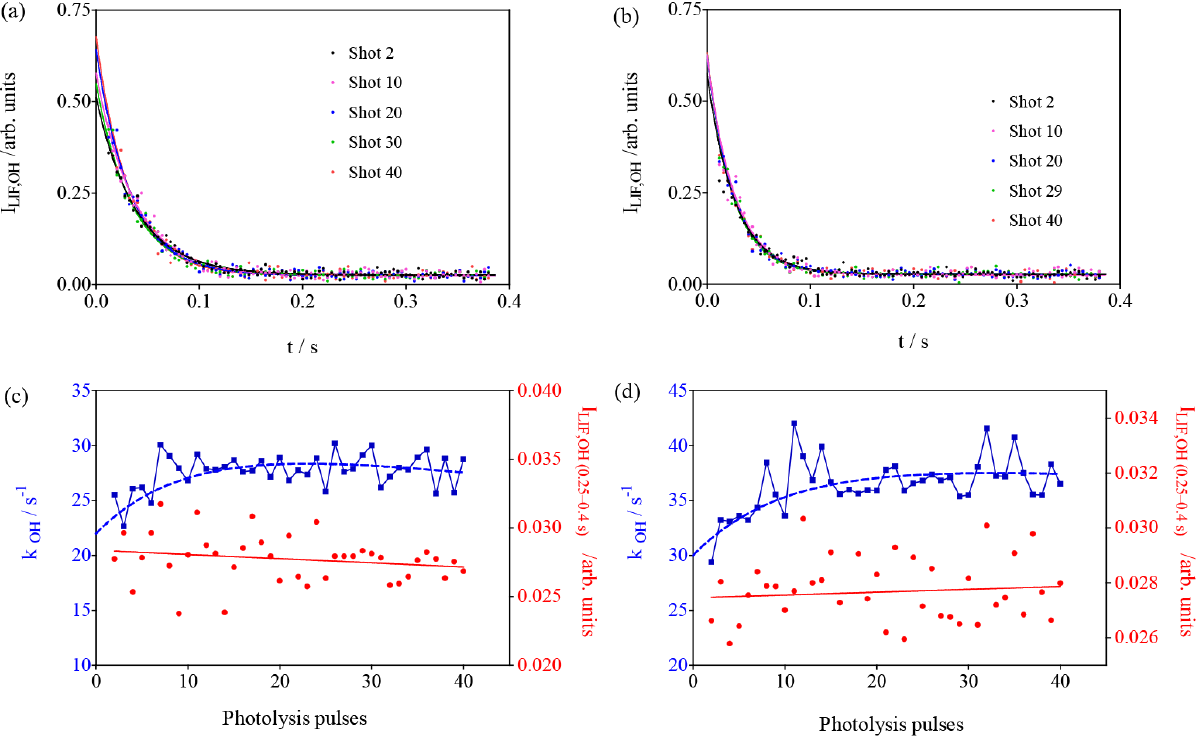
Figure 8. Photolysis of O 3 in the presence of different concentrations of CH 4 (3 . 3 × 10 15 cm − 3 and 4.9 × 10 15 cm − 3 for (a–d) , respectively). (a, b) OH decays (for clarity only every 10th decay is shown); (c, d) decay rates of OH radicals as a function of photolysis pulses (blue dots, left y axis), residual LIF intensity taken as the average LIF intensity between 0.25 and 0.4s s (red dots, right y